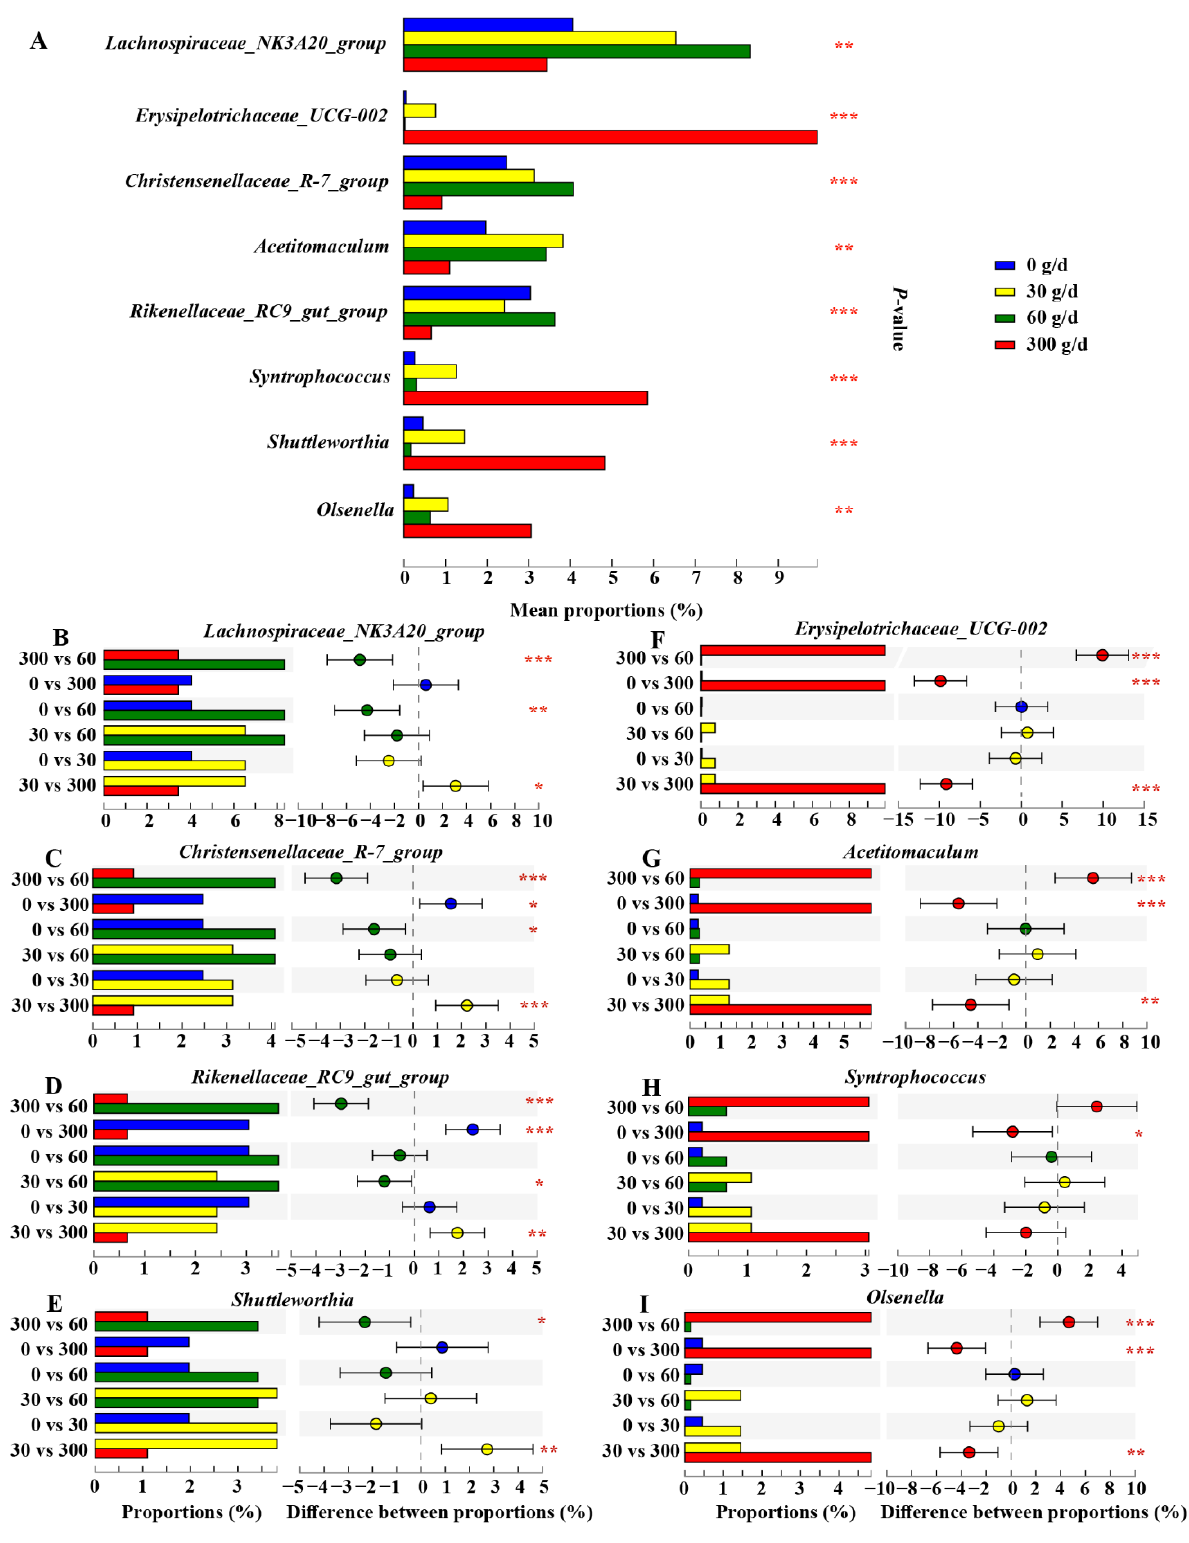
Figure 7. Effects of different levels of Acremonium terricola culture supplementation on the relative abundance of ruminal core genera (≥1%) in lactating dairy cows. The figure only shows the signifi- cantly different genera. The Kruskal–Wallis H test was used. *, 0.01 < P ≤ 0.05; **, 0.001 < P ≤ 0.01; ***, P ≤ 0.001. n = 6.